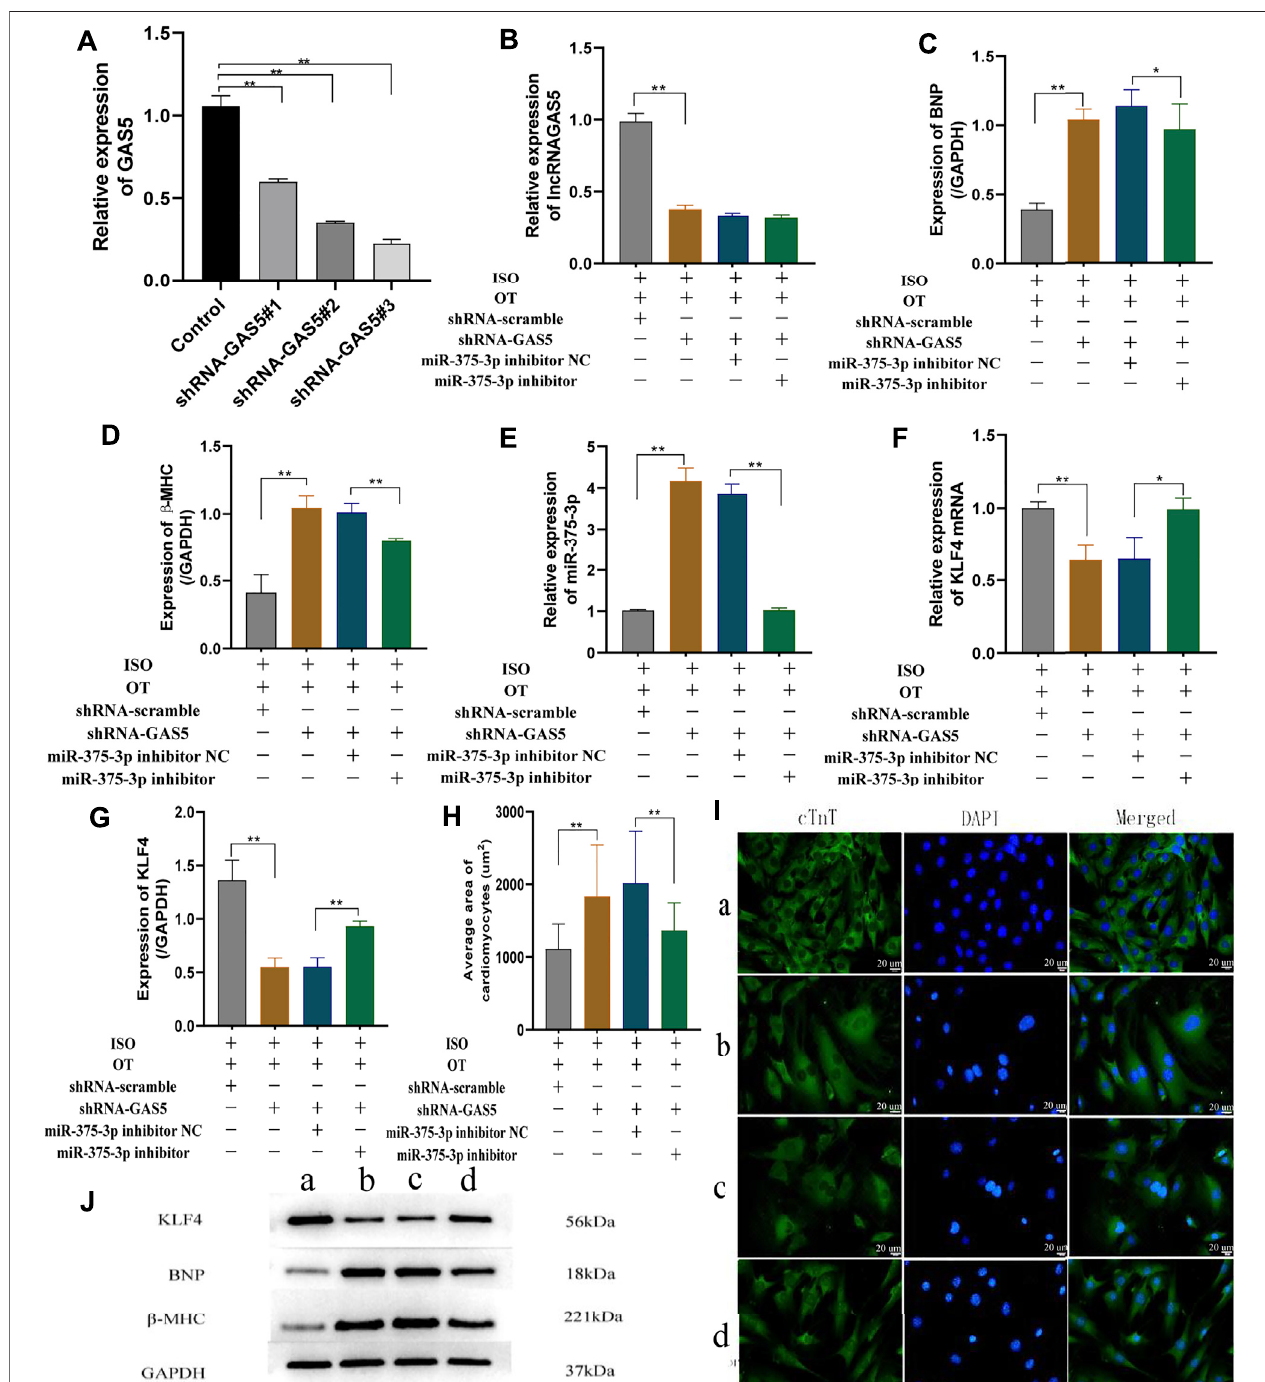
FIGURE 7 | Down-regulation of lncRNA GAS5 inhibits the anti-hypertrophic effects of OT via miR-375-3p in ISO-treated primary cardiomyocytes. (A) qRT-PCR was performed to quantitatively measure lncRNA GAS5 expression after transfection of shRNA-GAS5#1, shRNA-GAS5#2, shRNA-GAS5#3 in cardiomyocytes. (B) Expression of lncRNA GAS5 was determined by qRT-PCR. (C,D) Expressions of BNP and β -MHC proteins were measured by Western blot analysis. (E) Expression of miR-375-3p was determined by qRT-PCR. (F) Expression of KLF4 mRNA was determined by qRT-PCR. (G) Expression of KLF4 protein was determined by Westernblotanalysis. (H) Statisticalresultsofmeasurementofcellsurfaceareas. (I) Cardiomyocytesurfaceareasweremeasured byimmuno fl uorescentstaining.Scale bars represent 20 µm. Images were captured at × 400 magni fi cation (J) Representative Western blot images of KLF4, BNP, β -MHC and GAPDH. (a) ISO+OT+shRNA- scramble group. (b) ISO+OT+shRNA-GAS5 group. (c) ISO+OT+shRNA-GAS5+miR-375-3p inhibitor NC group. (d) ISO+OT+shRNA-GAS5+miR-375-3p inhibitor group. Data are shown as the mean ± sd of three independent experiments. *, p < 0.05; **, p < 0.01.